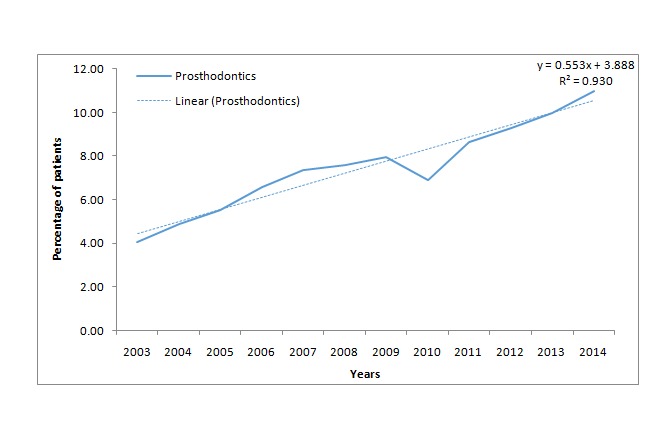
Graph 6: Trend line showing variation of referrals to prosthodontics department.